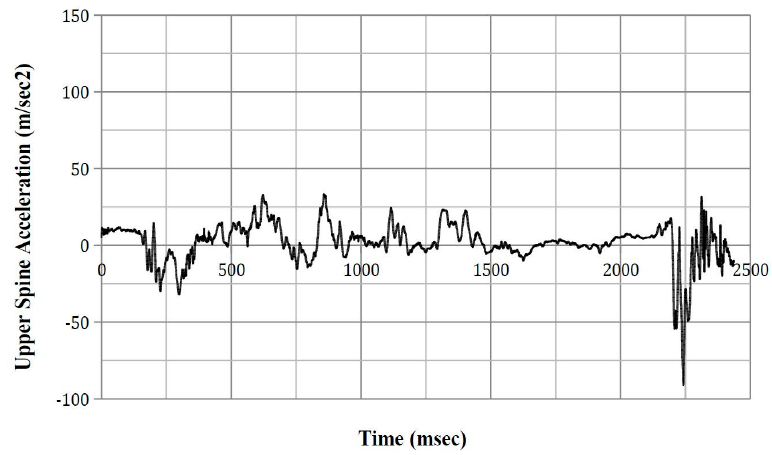
Figure A16. ATD Position 5 lower spine acceleration.